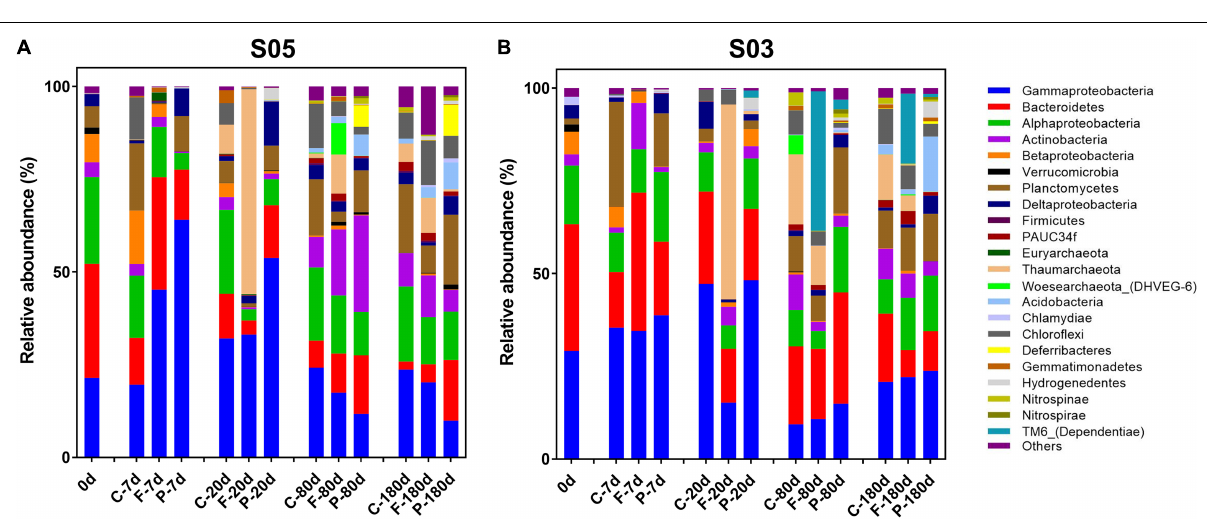
FIGURE 4 | Active microbial community composition based on 16S rRNA variations at station (A) S05 and (B) S03 throughout the incubations, shown at the phylum level (except for Proteobacteria, which are divided into classes). C-, control; F-, 0.22–3 µ m size fraction (free-living fraction); and P-, > 3 µ m size fraction (particle-associated